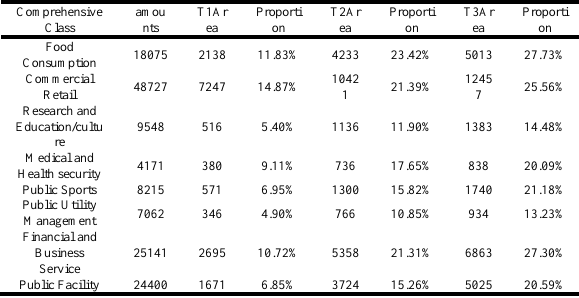
Table 1. Proportion of comprehensive classes in three areas (In order to avoid confusion due to the large number of detail)